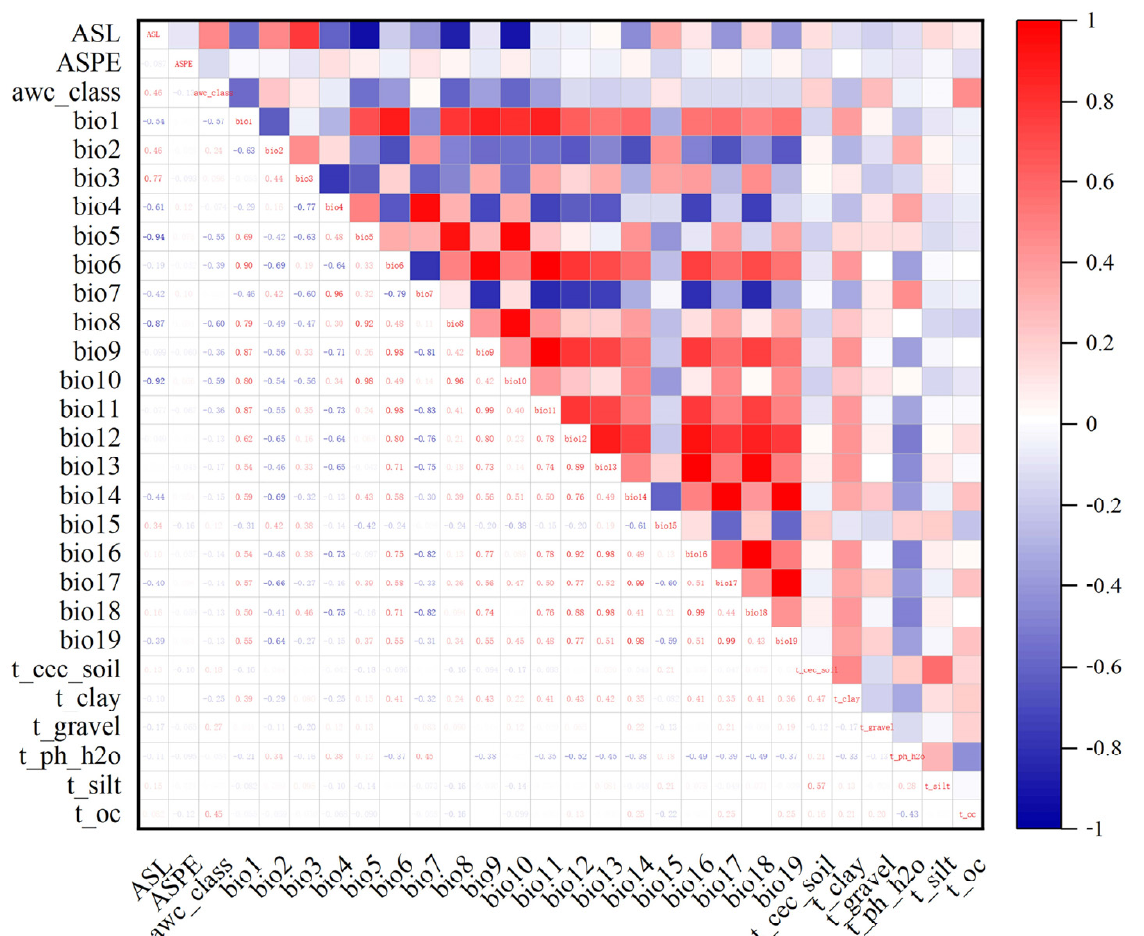
Figure 1. Correlation analysis of various environmental factors. The data in the lower left half of the graph represent the correlation coefficient values between environmental variables. Red represents positive correlations, and blue represents negative correlations. The deep red and blue represent higher correlation coefficients between two variables. The explanations of the variables are provided in Table 1.